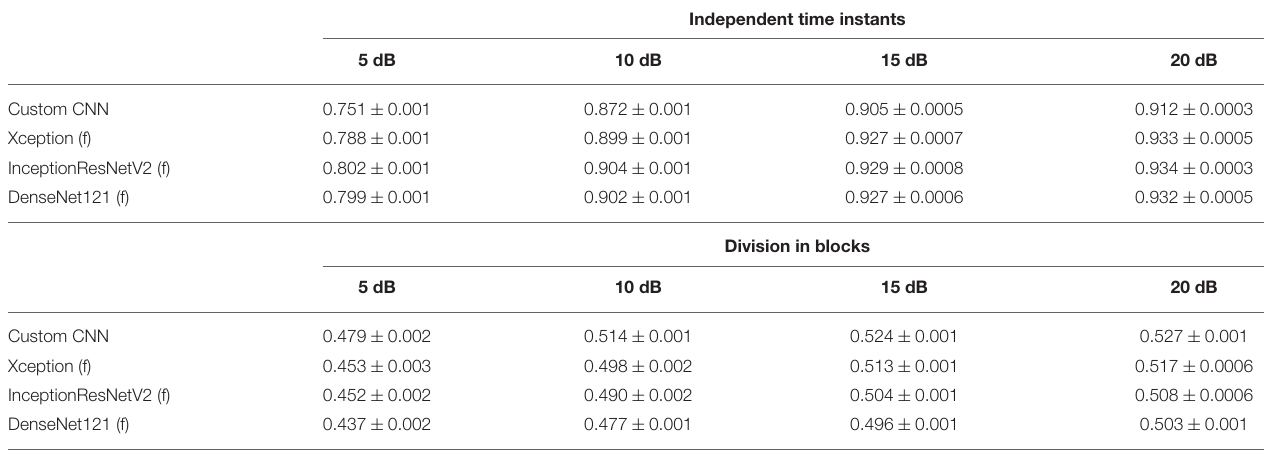
TABLE 3 | Average accuracy values obtained for the different fully trained networks and noisy PSD (SNR = 5, 10, 15 and 20 dB, test